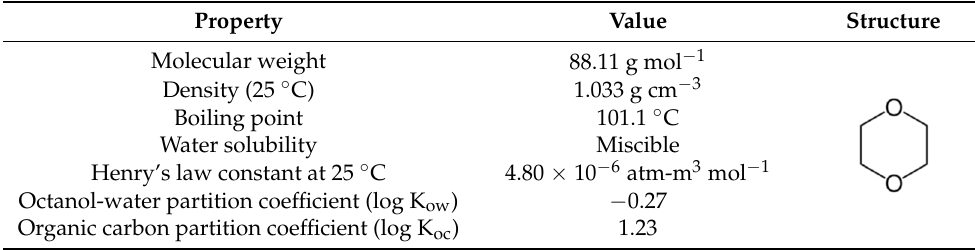
Table 1. Physical properties of 1,4-dioxane *.